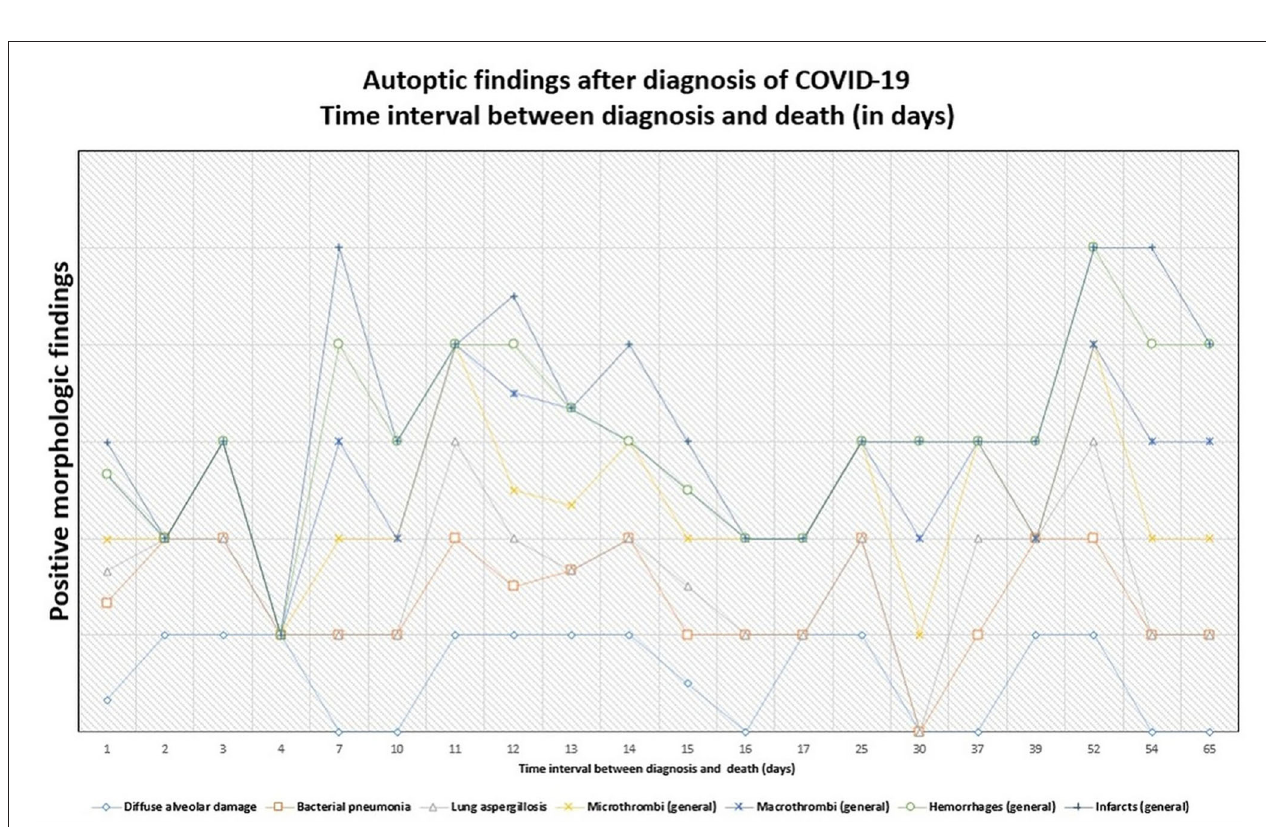
FIGURE 6 | Persistence of histopathologic findings in relation to the time interval between diagnosis and death (in days). The lines do not show absolute percentages but only the relative variation in prevalence of the findings. The different levels of the line along the y-axis are chosen to avoid their overlapping and to facilitate the visual interpretation but do not reflect an absolute percentage, for which we refer the reader to the text.